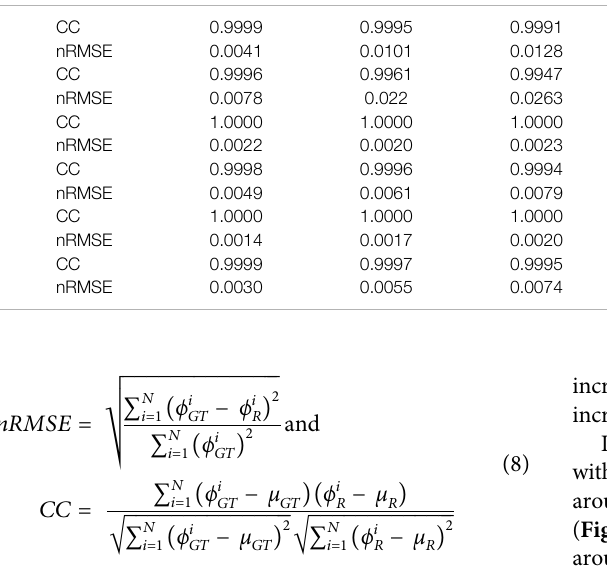
TABLE 1 | Effects of number of points on sampling boundary Γ C represented in Figure 2A and its location relative to outer boundary Γ H on the accuracy with which potentialsandnormalpotentialgradientson Γ C arereconstructed.Potentialdistributionin Ω H shownin Figure2A . Γ C isconcentricwith Γ H andtheradiusoftheformeris increased as indicated by the area ratio Ω C relative to Ω H . Samples are acquired at 8,16 and 32 uniformly spaced points around Γ C . Area